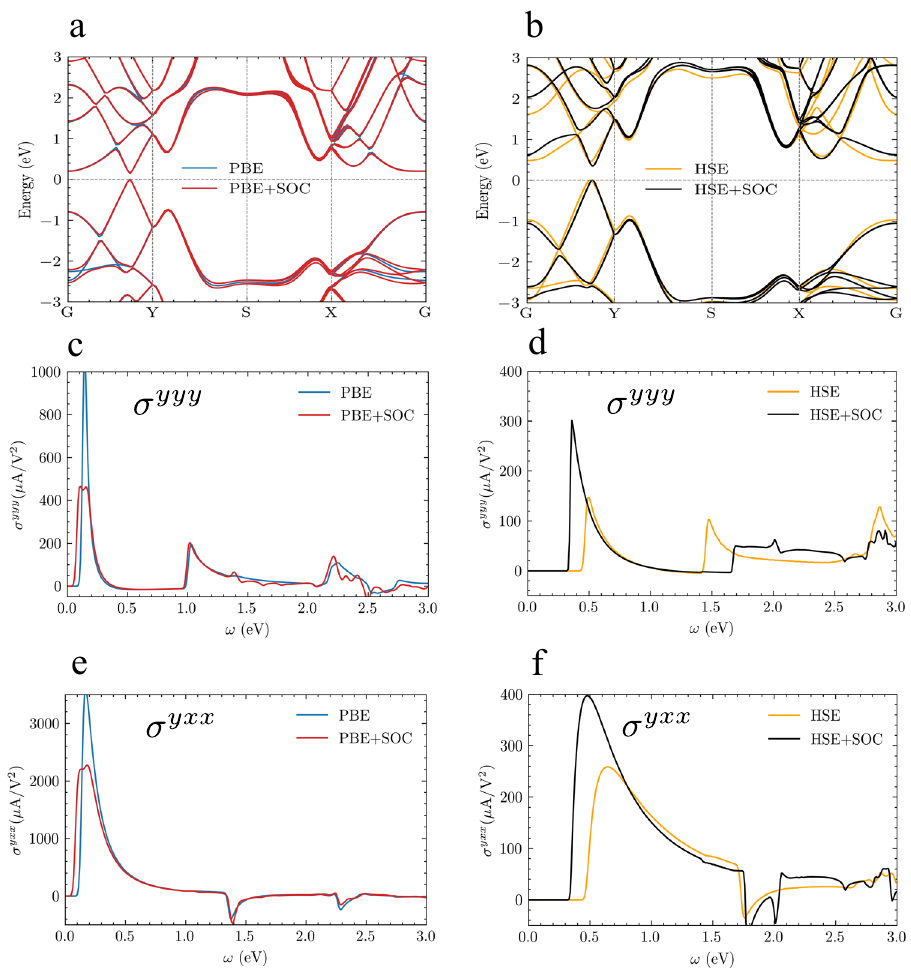
Fig. 2 Electronic band structures and shift current spectra of monolayer As. Band structures computed with a PBE and PBE + SOC and b HSE and HSE + SOC. σ yyy spectra computed with c PBE and PBE + SOC and d HSE and HSE + SOC. σ yxx spectra computed with e PBE and PBE + SOC and f HSE and HSE +